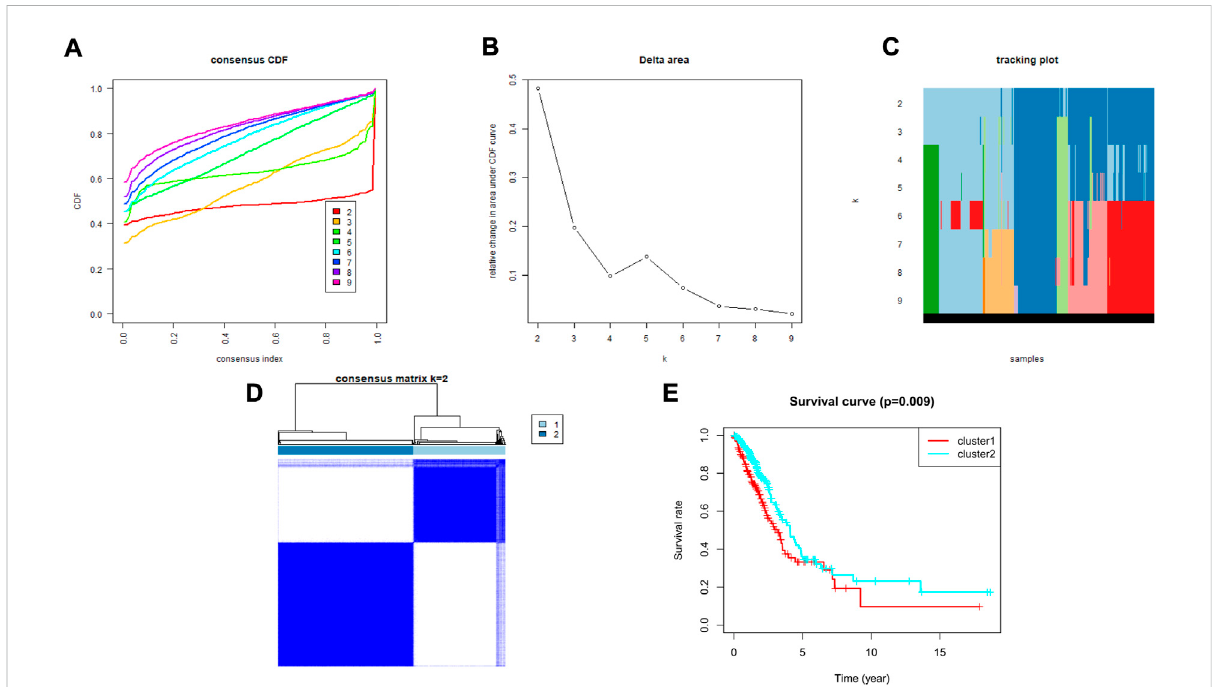
FIGURE 2 Tumorclassi fi cationbasedontheHMMRs. (A) Consensusclusteringcumulativedistributionfunction(CDF)fork=2to9. (B) Thechangesinthe area under the CDF curve for k = 2 to 9. (C) The tracking plot for k = 2 to 9. (D) The optimal consensus clustering matrix when k = 2; (E) The Kaplan – Meier OS curves for the two